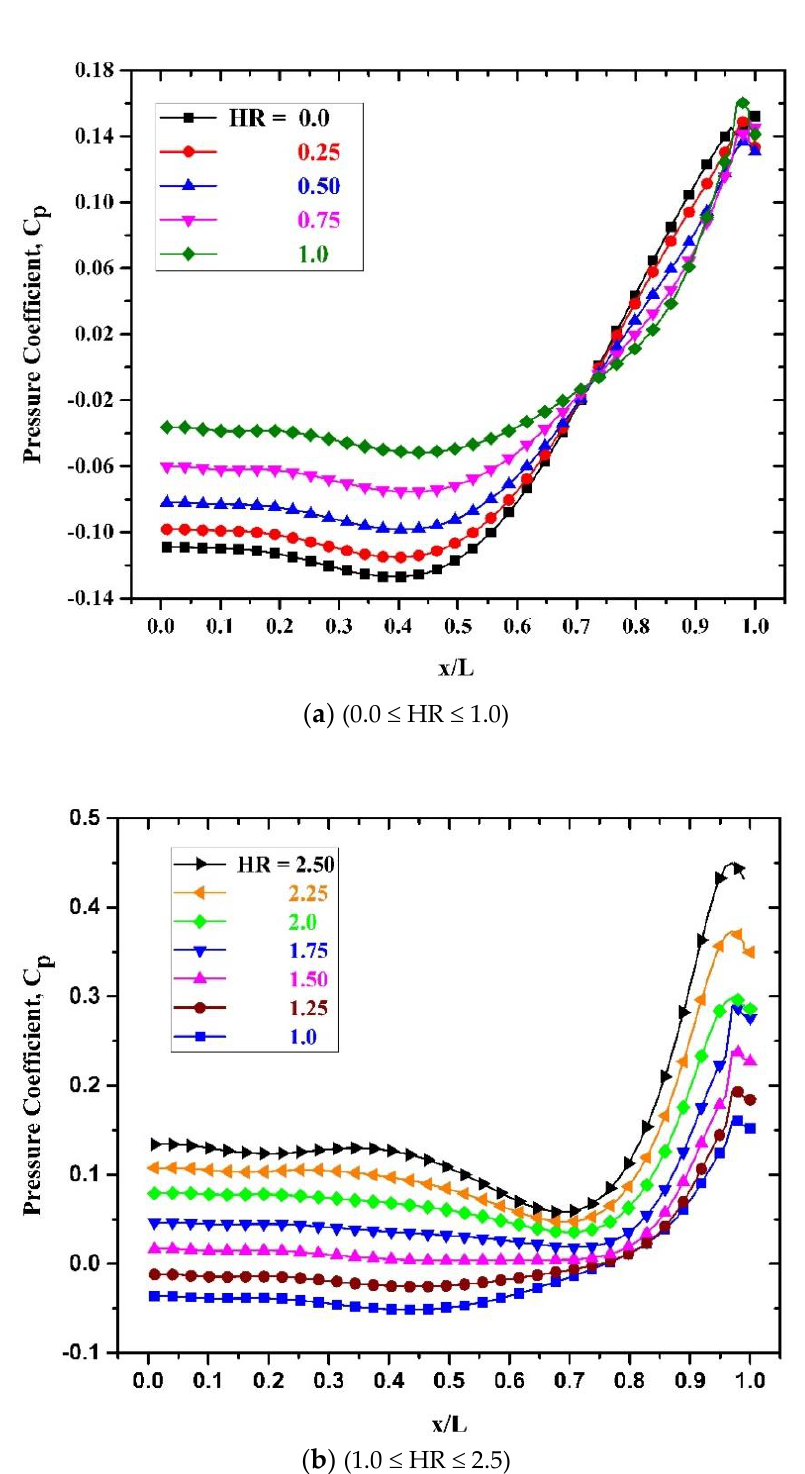
Figure 10. Distribution of static pressure coefficient C p along cavity bottom wall at different height ratios.